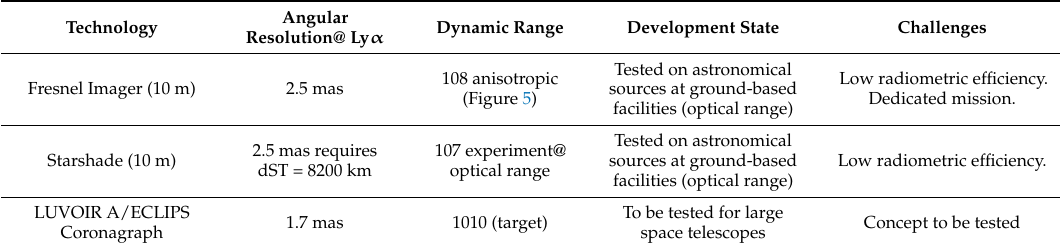
Table 1. Summary of